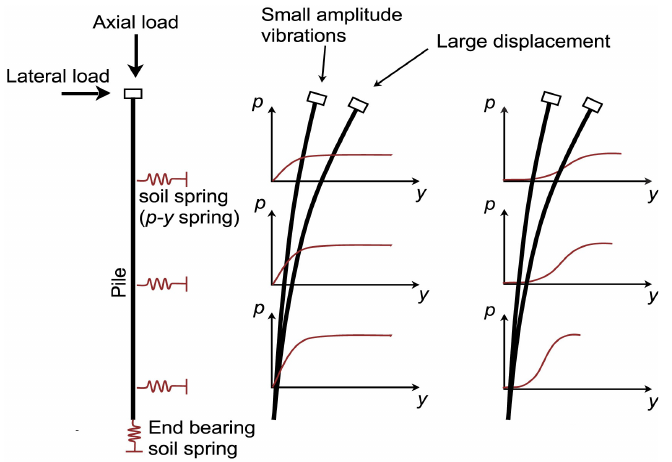
Figure 11. Comparison of soil–structure interaction modeling using traditional p-y curves for liquefiable soils.